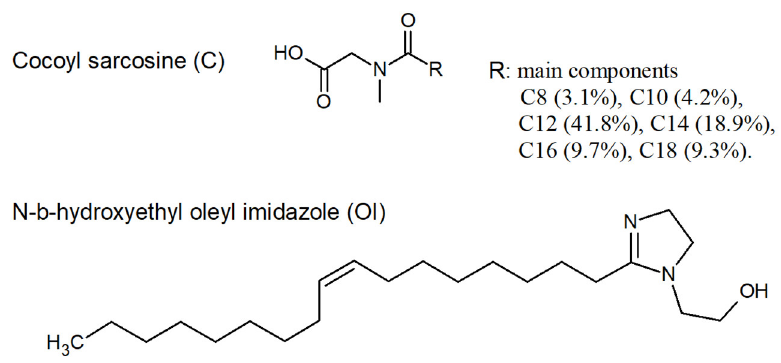
Figure 1. Schematic of the inhibitors used, including the composition of present C. For the evaluation of the inhibitory effect of C, OI and C + OI via electrochemical measures and spray corrosion the dip coating was arranged for 10 min at all